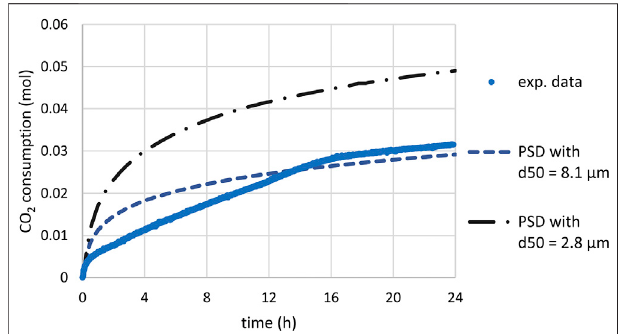
FIGURE 12 | Time-CO 2 consumption during slag carbonation (T (cid:2) 180 ° C, P CO2 (cid:2) 20 bar) under attrition with sand quartz: comparison of experimental data and predictions of models assuming a diffusion-limiting process ( D eH + (cid:2) 1.3 × 10 – 11 m 2 s − 1